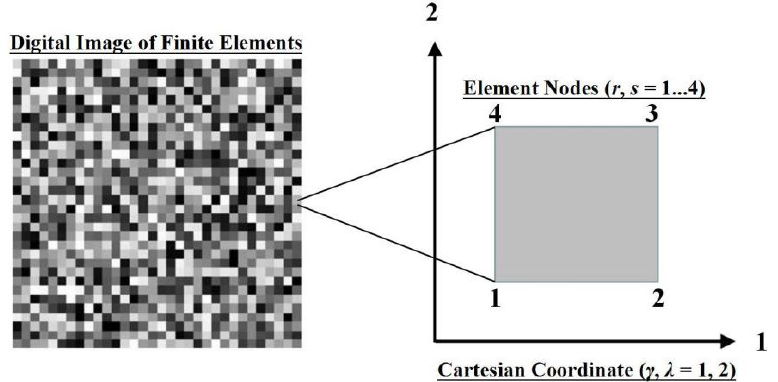
Figure 6. Schematic of the Cartesian coordinates and element nodes for the two-dimensional finite element method.